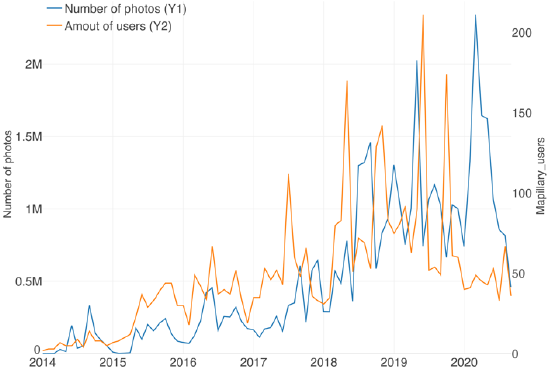
Figure 1 . Monthly Mapillary data acquisition dates and number of participating users.